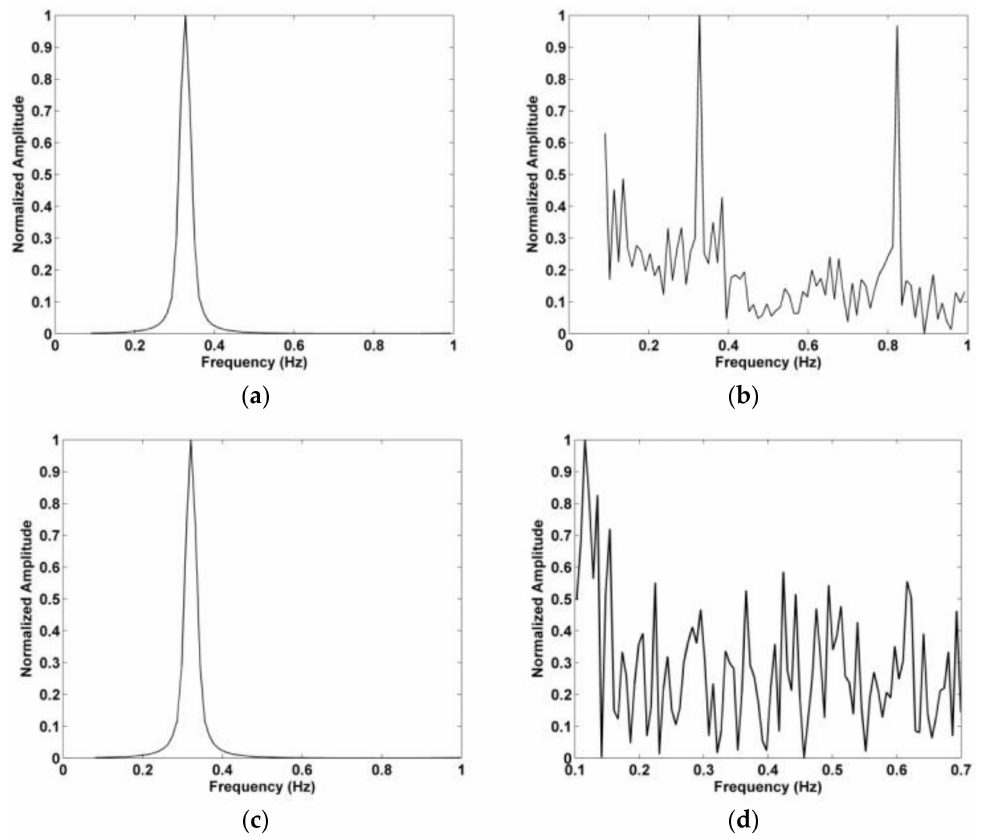
Figure 23. ( a ) Frequency estimation using the proposed method at 400 cm, ( b ) frequency estimation using an FFT at 400 cm, ( c ) frequency estimation using the proposed method at 700 cm, and ( d ) frequency estimation using an FFT at 700 cm.